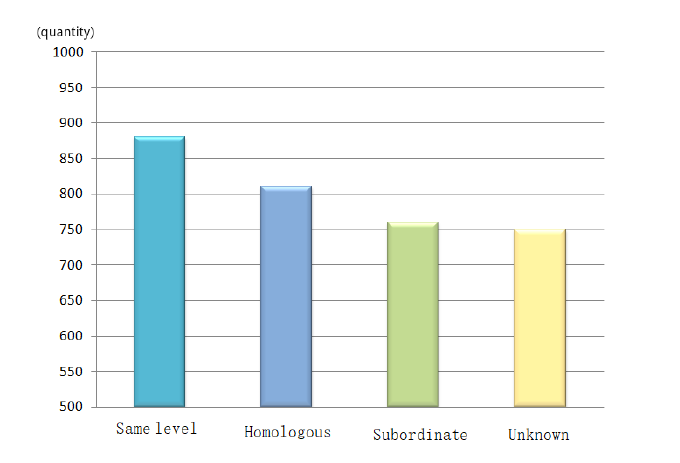
Figure 14. Data statistics of training data of four kinds of